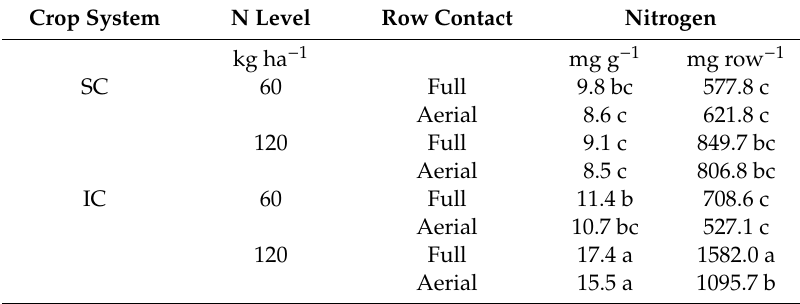
Table 8. Nitrogen concentration and content in the shoots of triticale, as a ff ected by the Crop system × N level × Row contact interaction. SC, sole crop; IC, intercrop. For each parameter, values followed by the same letter within a column are not significantly di ff erent at P < 0.05, Tukey’s